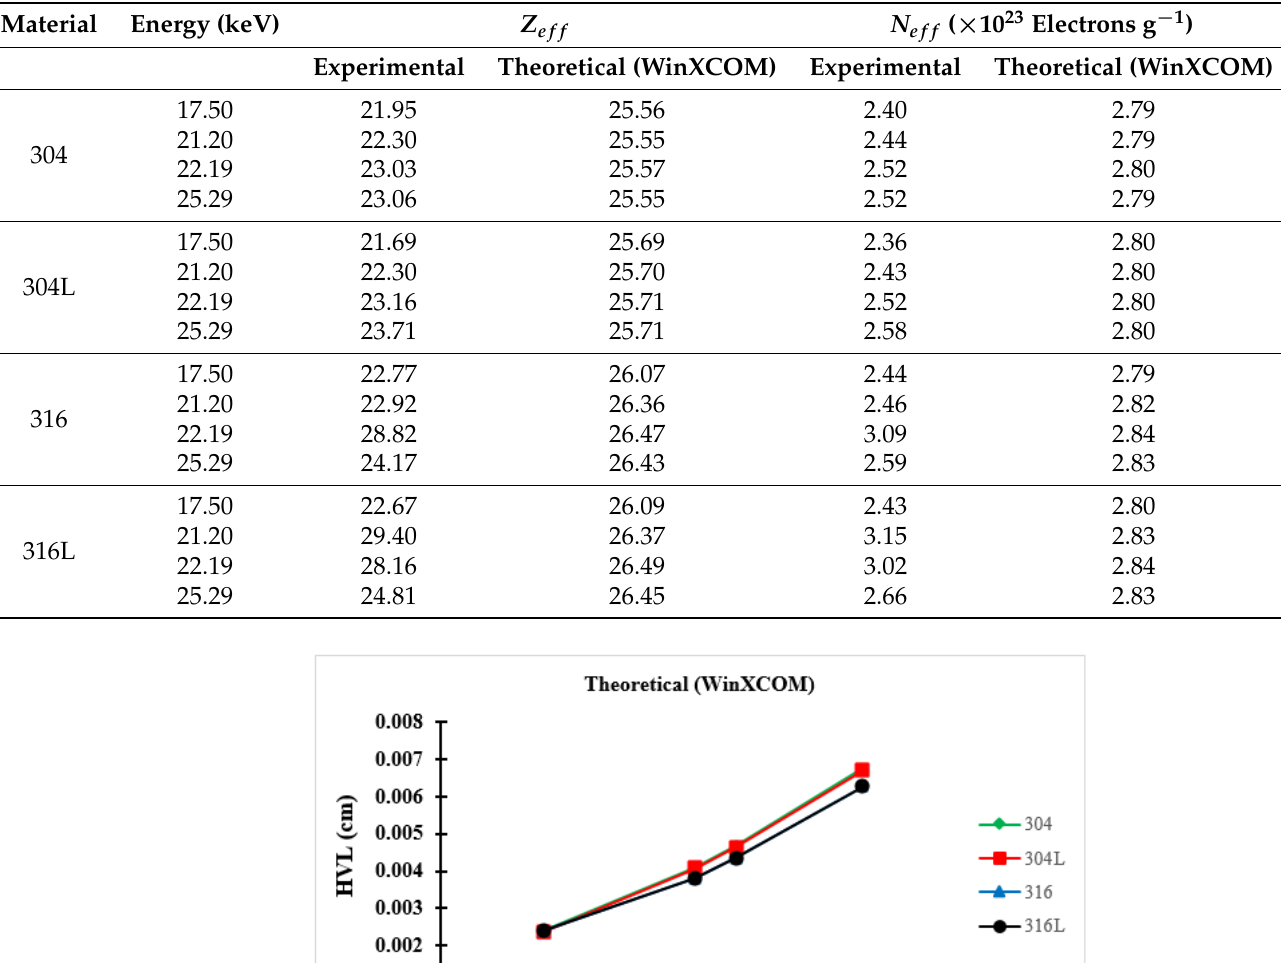
Table 4. The effective atomic number and effective electron density of the stainless-steel samples.